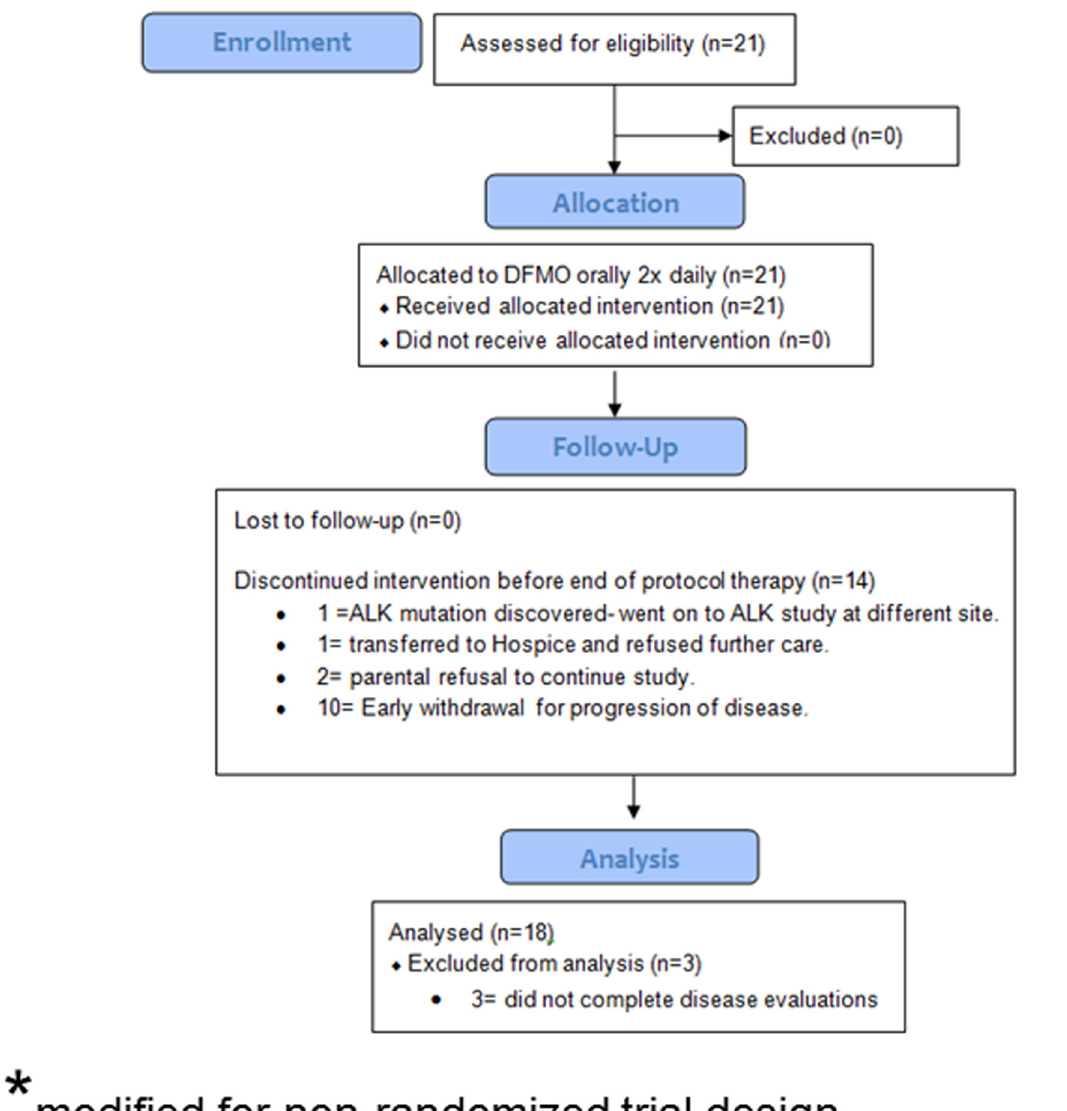
Fig 1. NMTRC002 CONSORT Flow Diagram- modified for non-randomized trial design.